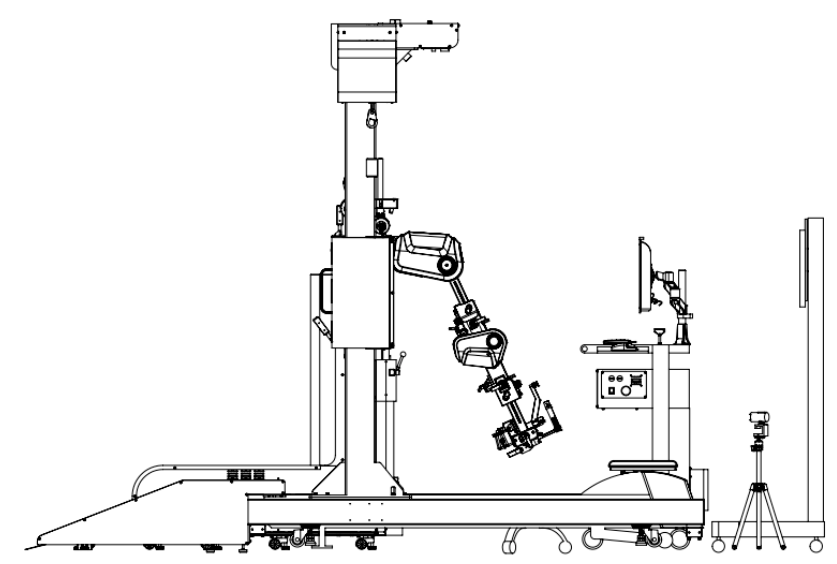
Figure 1 . Robot interactive gait training Walkbot. Figure 1. Robot interactive gait training Walkbot. Figure 1. Robot interactive gait training Walkbot.